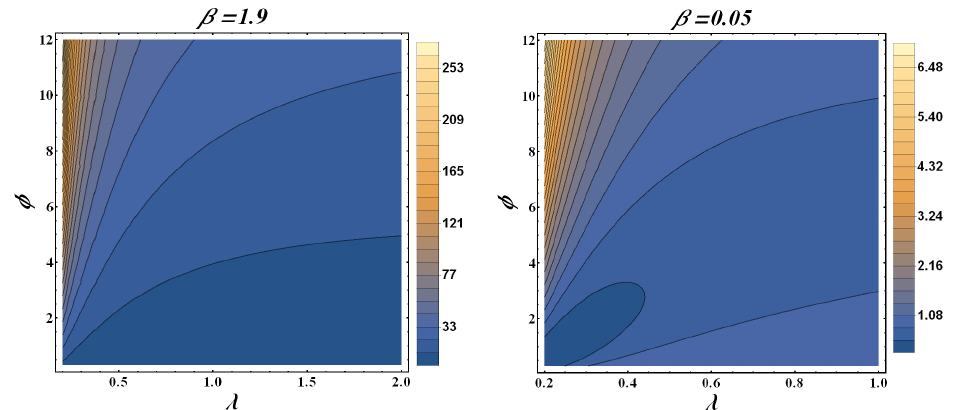
(cid:0) ˘ Θ (cid:1) Figure 5. Plots of skewness of HLUG-TI for certain parameter values. Fig. 5. Plots of skewness of HLUG-TI for certain parameter values.